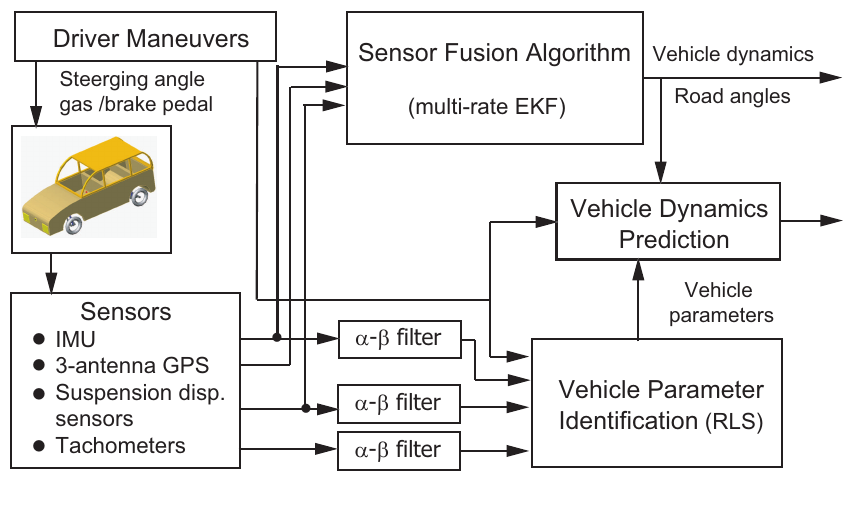
Figure 2. Block diagram of the vehicle dynamics prediction